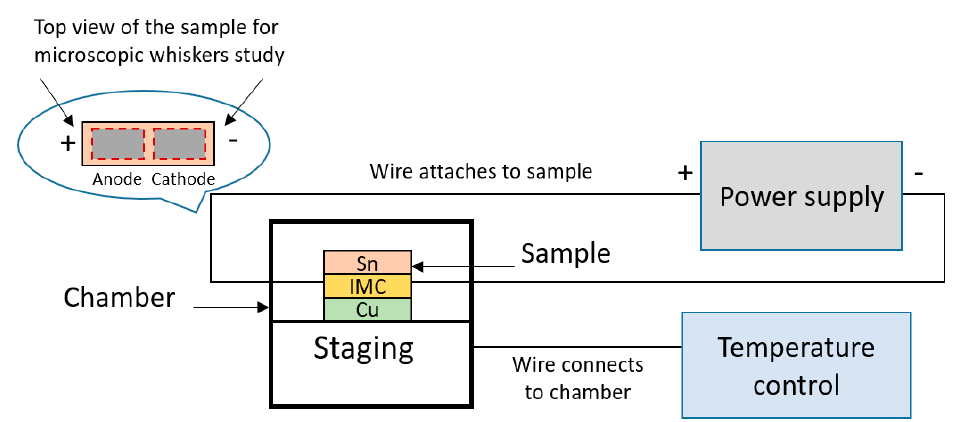
Figure 1. Schematic diagram of the electromigration and thermal ageing tests.